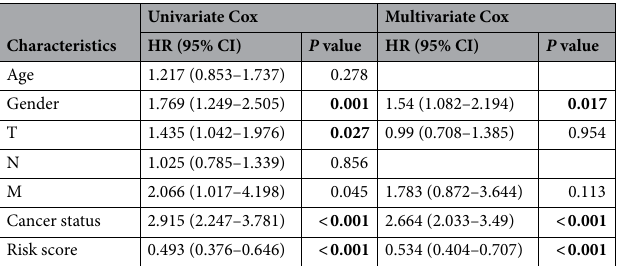
Table 2. Univariate and multivariate Cox analysis of the clinicopathological features and signature with OS. Significant value is given in bold.